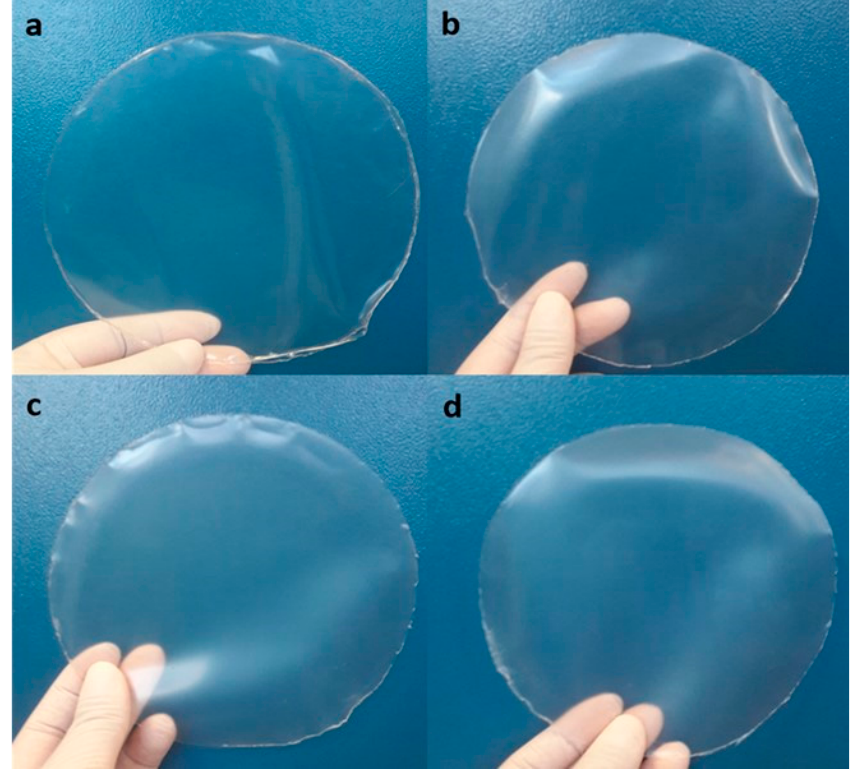
Figure 3. Cassava starch films containing quinoa starch nanocrystals at ( w / w ): ( a ) 0%, ( b ) 2.5%, ( c ) 5.0% and ( d ) 7.5%. Table 1. Thickness, moisture content, solubility in water, water vapor permeability (WVP), color